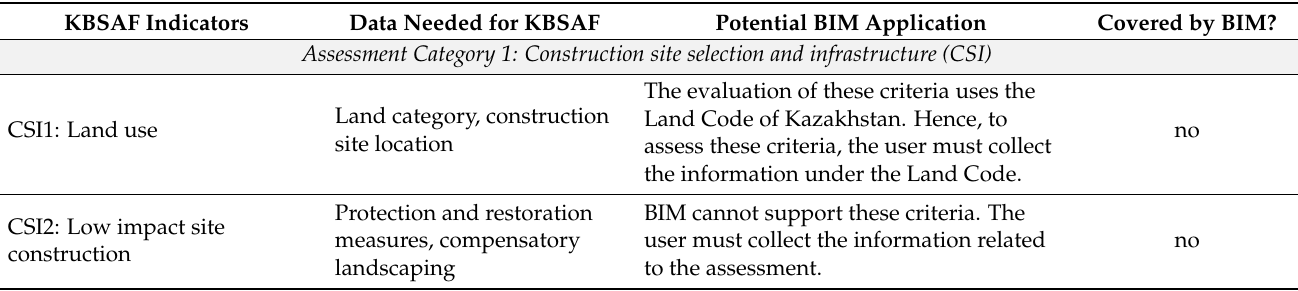
Table 3. Evaluating the potential BIM application for